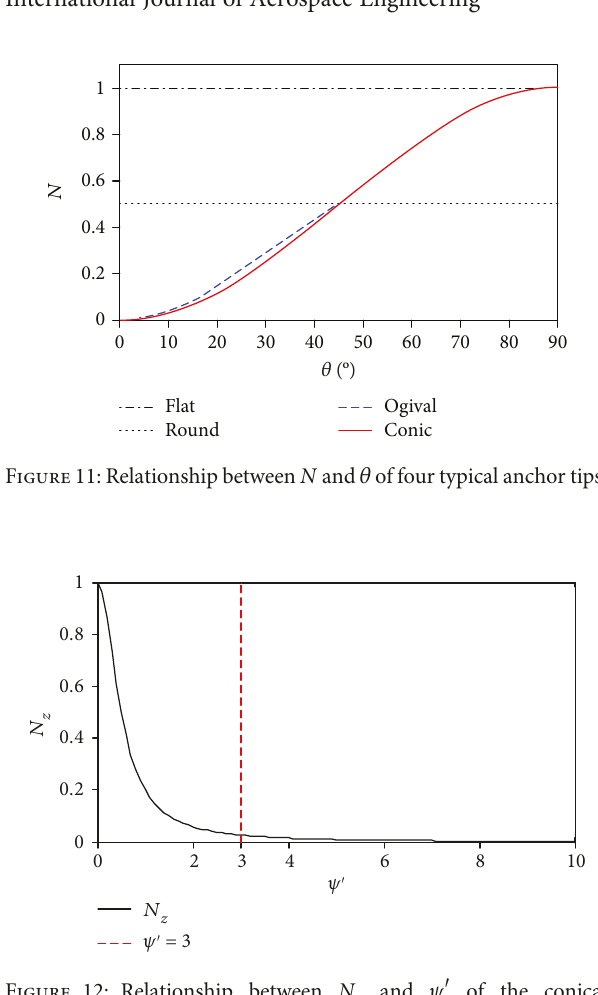
Figure 12: Relationship between N anchor tip.